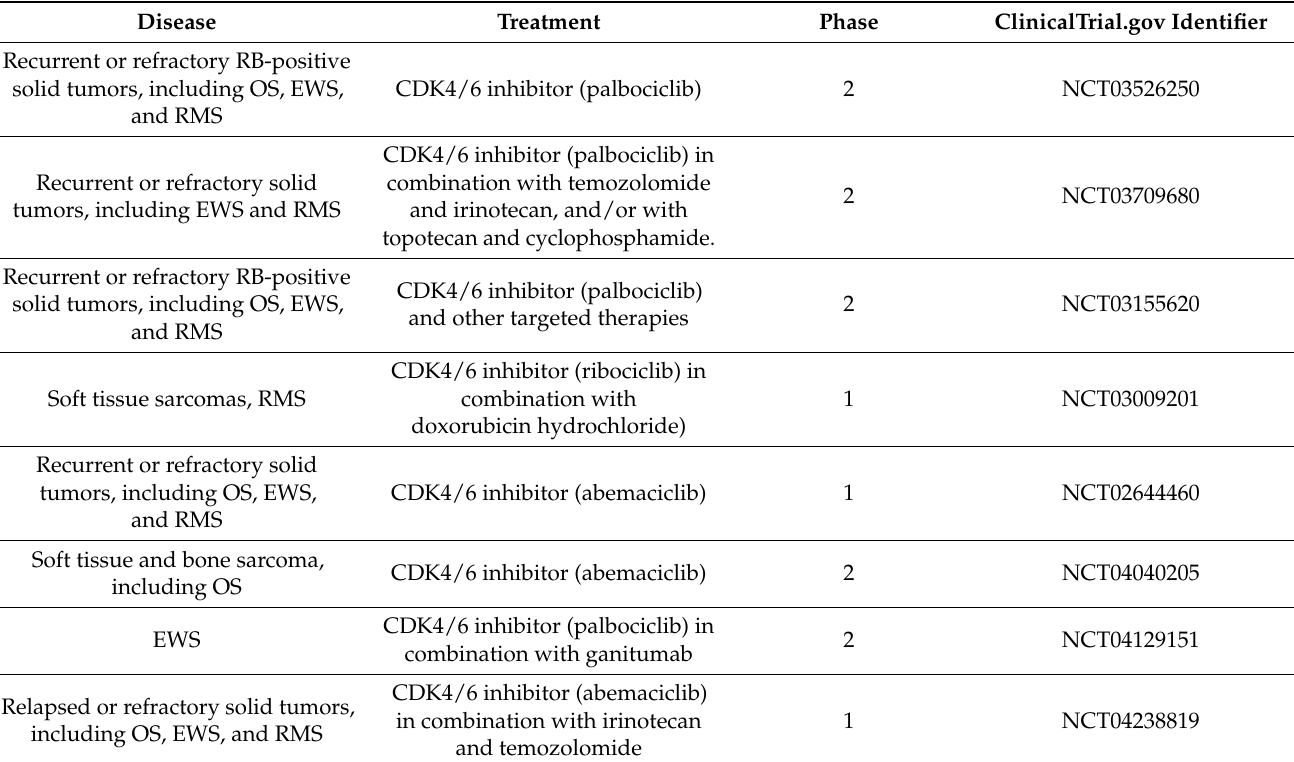
Table 2. Ongoing clinical trials on CDK4/6 inhibitors in pediatric and AYA sarcoma patients. Disease Treatment Phase ClinicalTrial.gov